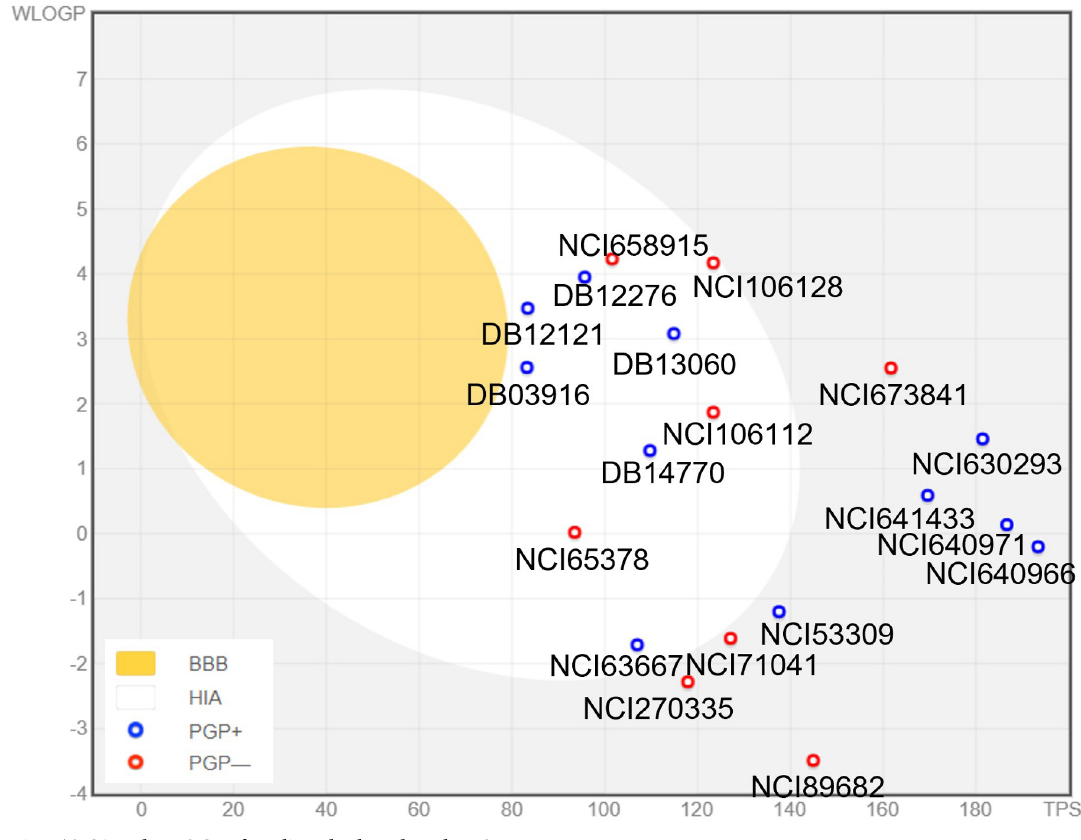
Fig 4. TPSA and WLOGP of top ligands plotted on the